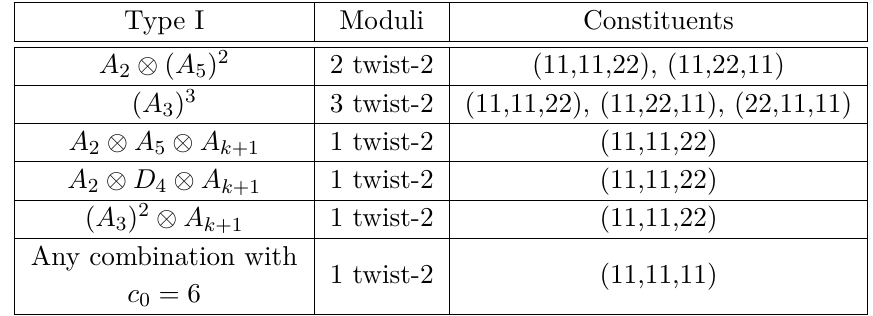
6 . Here we have k ∈ Z . 0 < > 0